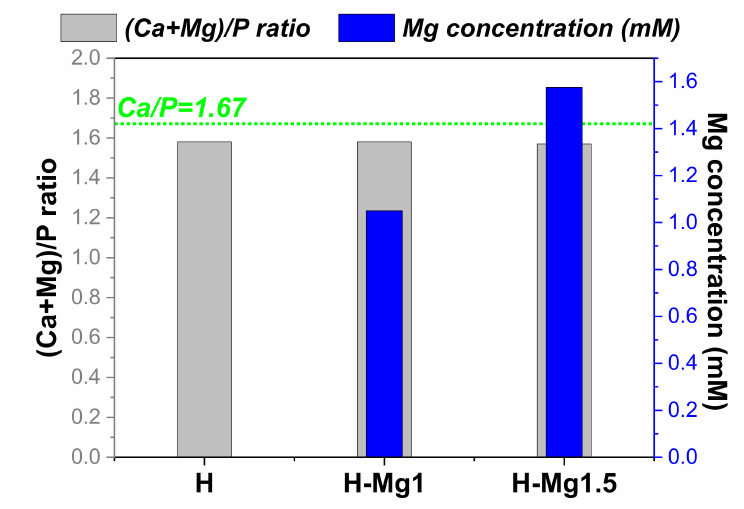
Figure 4. Dependency between (Ca + Mg) / P ratio and the Mg concentration.